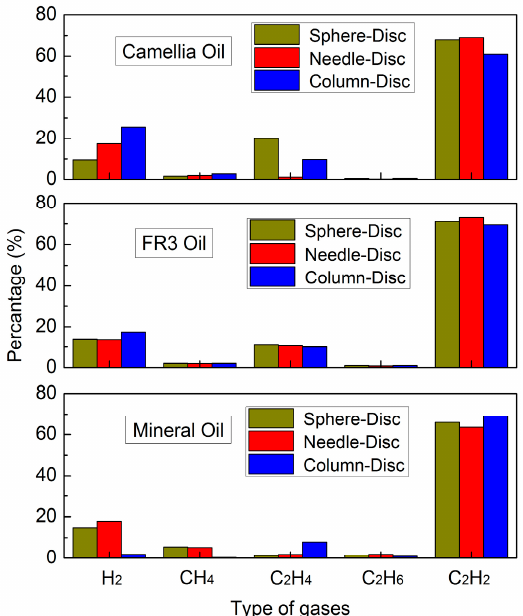
Figure 12. Relative percentages of fault gases in oil ‐ paper under breakdown.